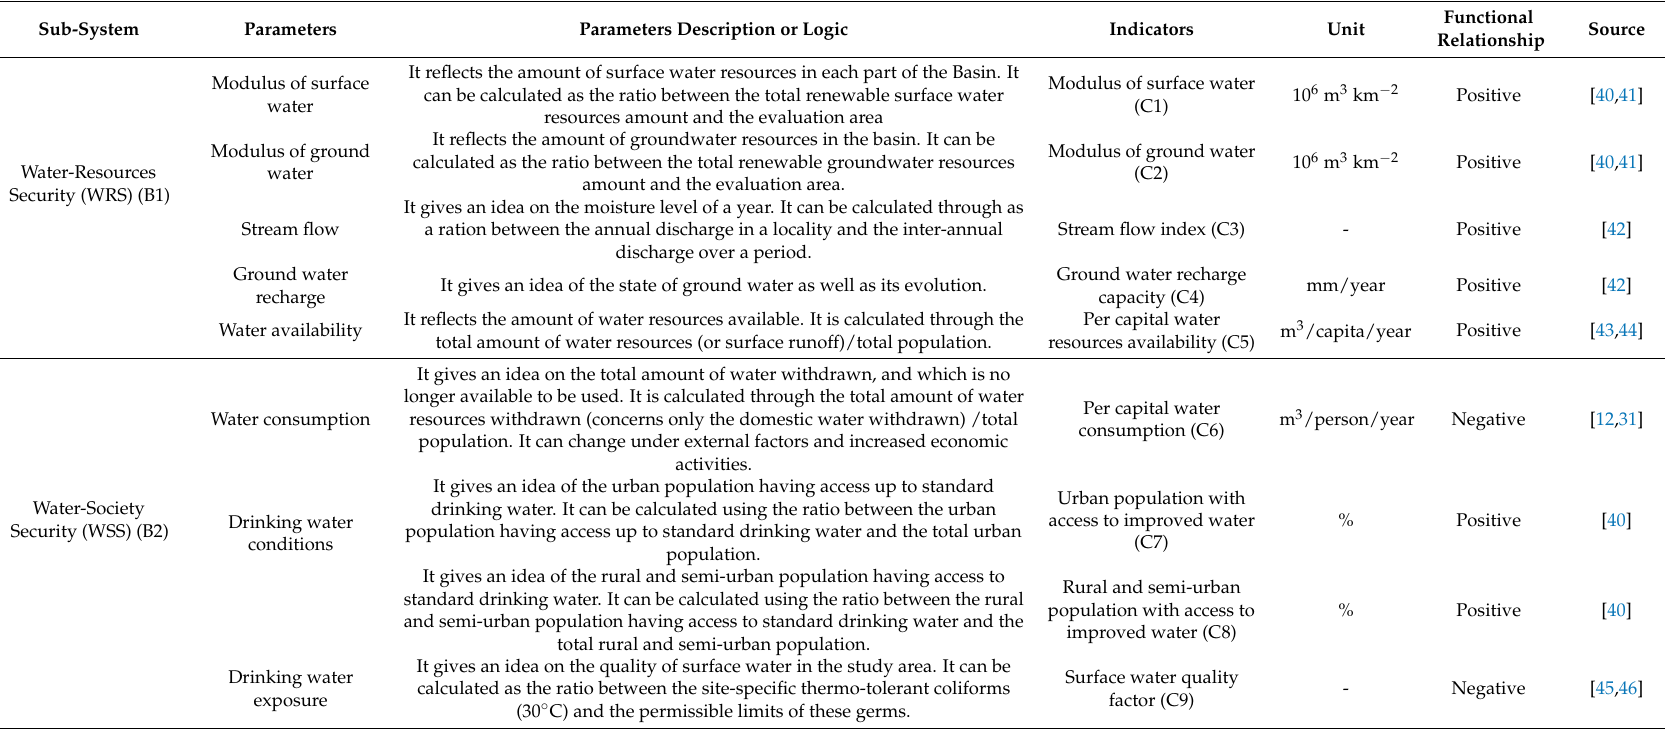
Table 1. Indicators for water security assessment in the Oti Nord